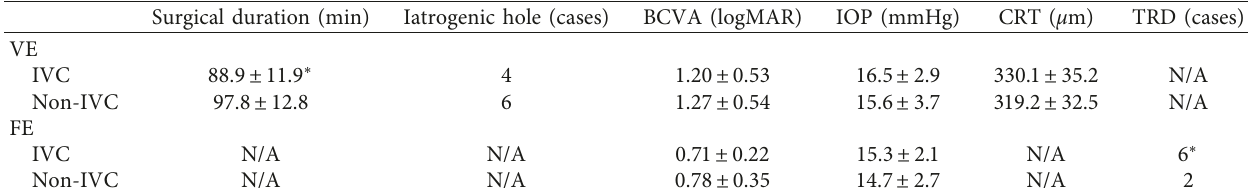
Table 2: Surgical details of the vitrectomized eye and data of both eyes during follow-up. Surgical duration (min)